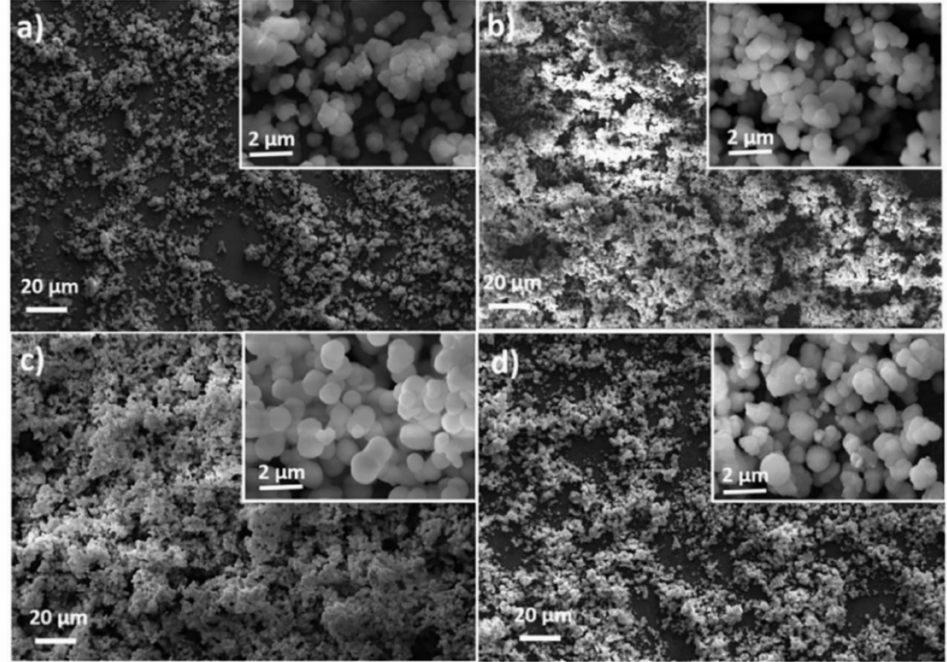
Figure 9. SEM micrographs obtained by Lopes et al. (Reproduced from [89], published by Elsevier, 2017.) of: ( a ) stainless steel; ( b ) DLC; ( c ) TiO 2 -DLC (0.1 g/L); and ( d ) TiO 2 -DLC (0.3 g/L) surfaces after